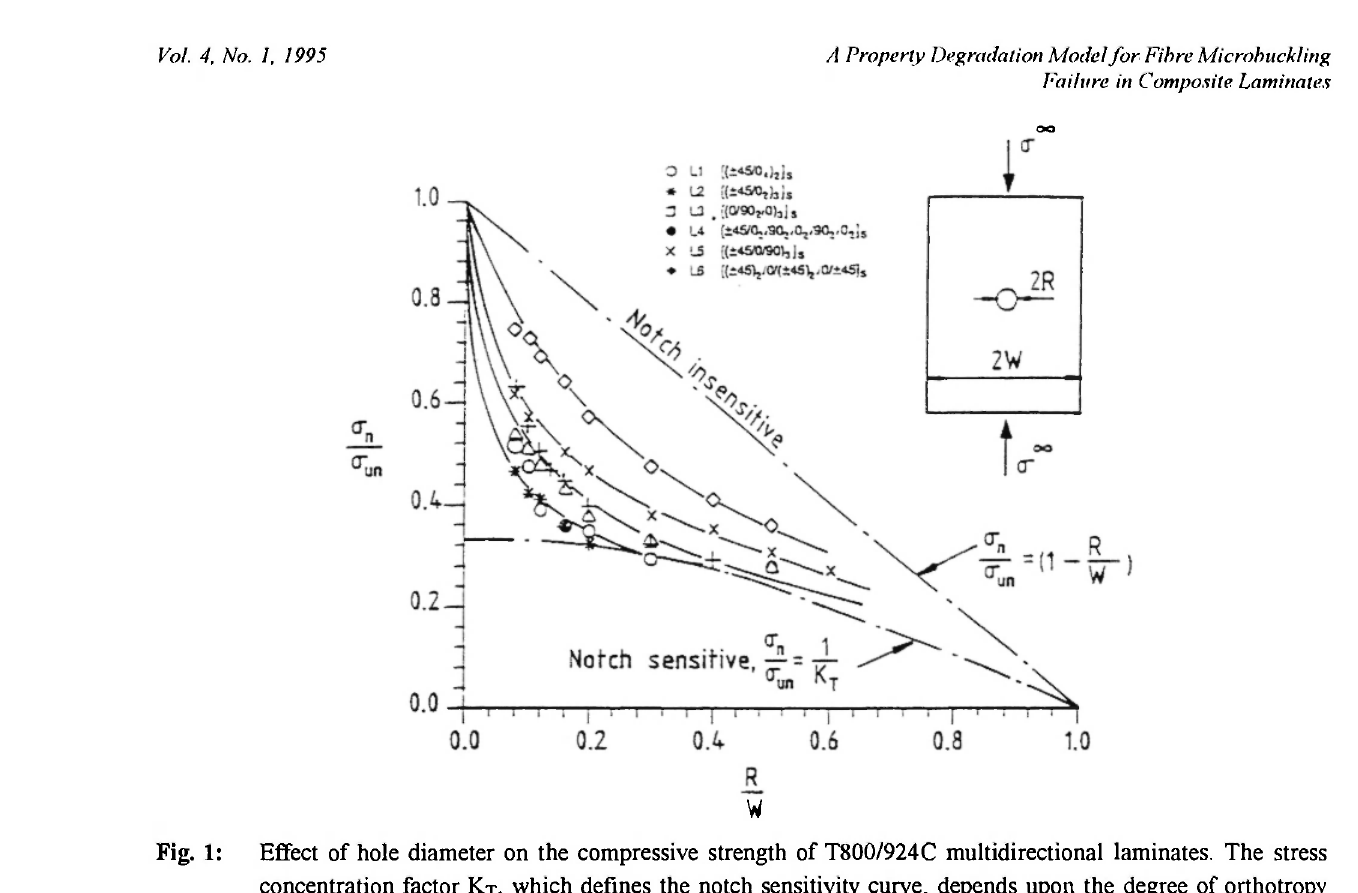
Fig. 1: Effect of hole diameter on the compressive strength of T800/924C multidirectional laminates. The stress concentration factor Κχ, which defines the notch sensitivity curve, depends upon the degree of orthotropy